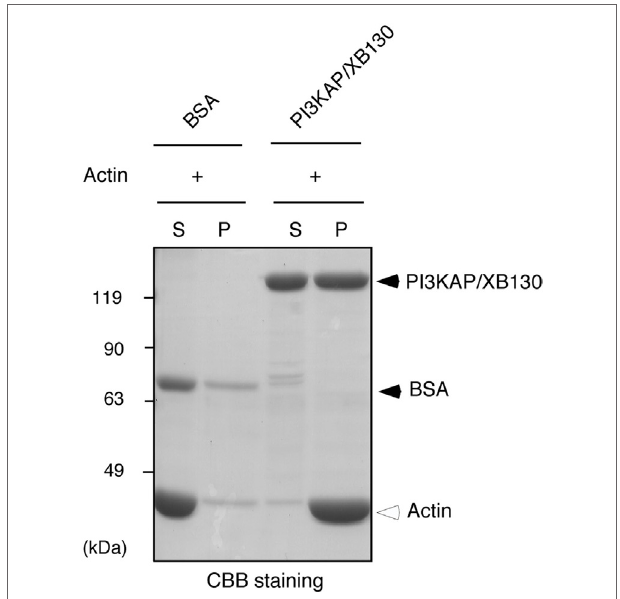
FigUre 3 | Pi3KaP/XB130 crosslinks actin filaments . Actin filaments polymerized in vitro were incubated with BSA or FLAG-tagged recombinant PI3KAP/XB130. The mixture was subjected to low-speed centrifugation, and the fractions of supernatant (S) and pellet (P) were separated by SDS-PAGE and then proteins were visualized by CBB